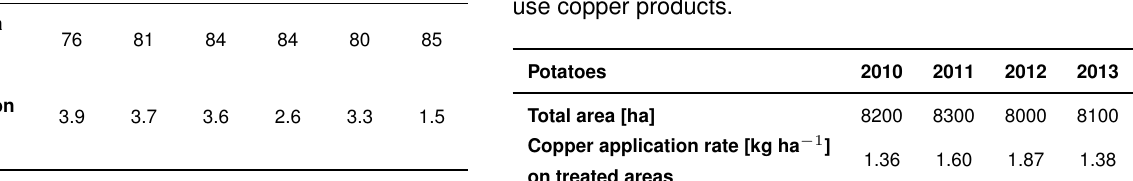
Table 8. Average copper application rates [kg ha − 1 ] in or- ganic potato-growing in 2010 to 2013 based on the size of the application area. Copper pesticides were applied to only about 40 to 50% of the cultivated area in organic farming. Demeter Association member farms are not permitted to use copper products.